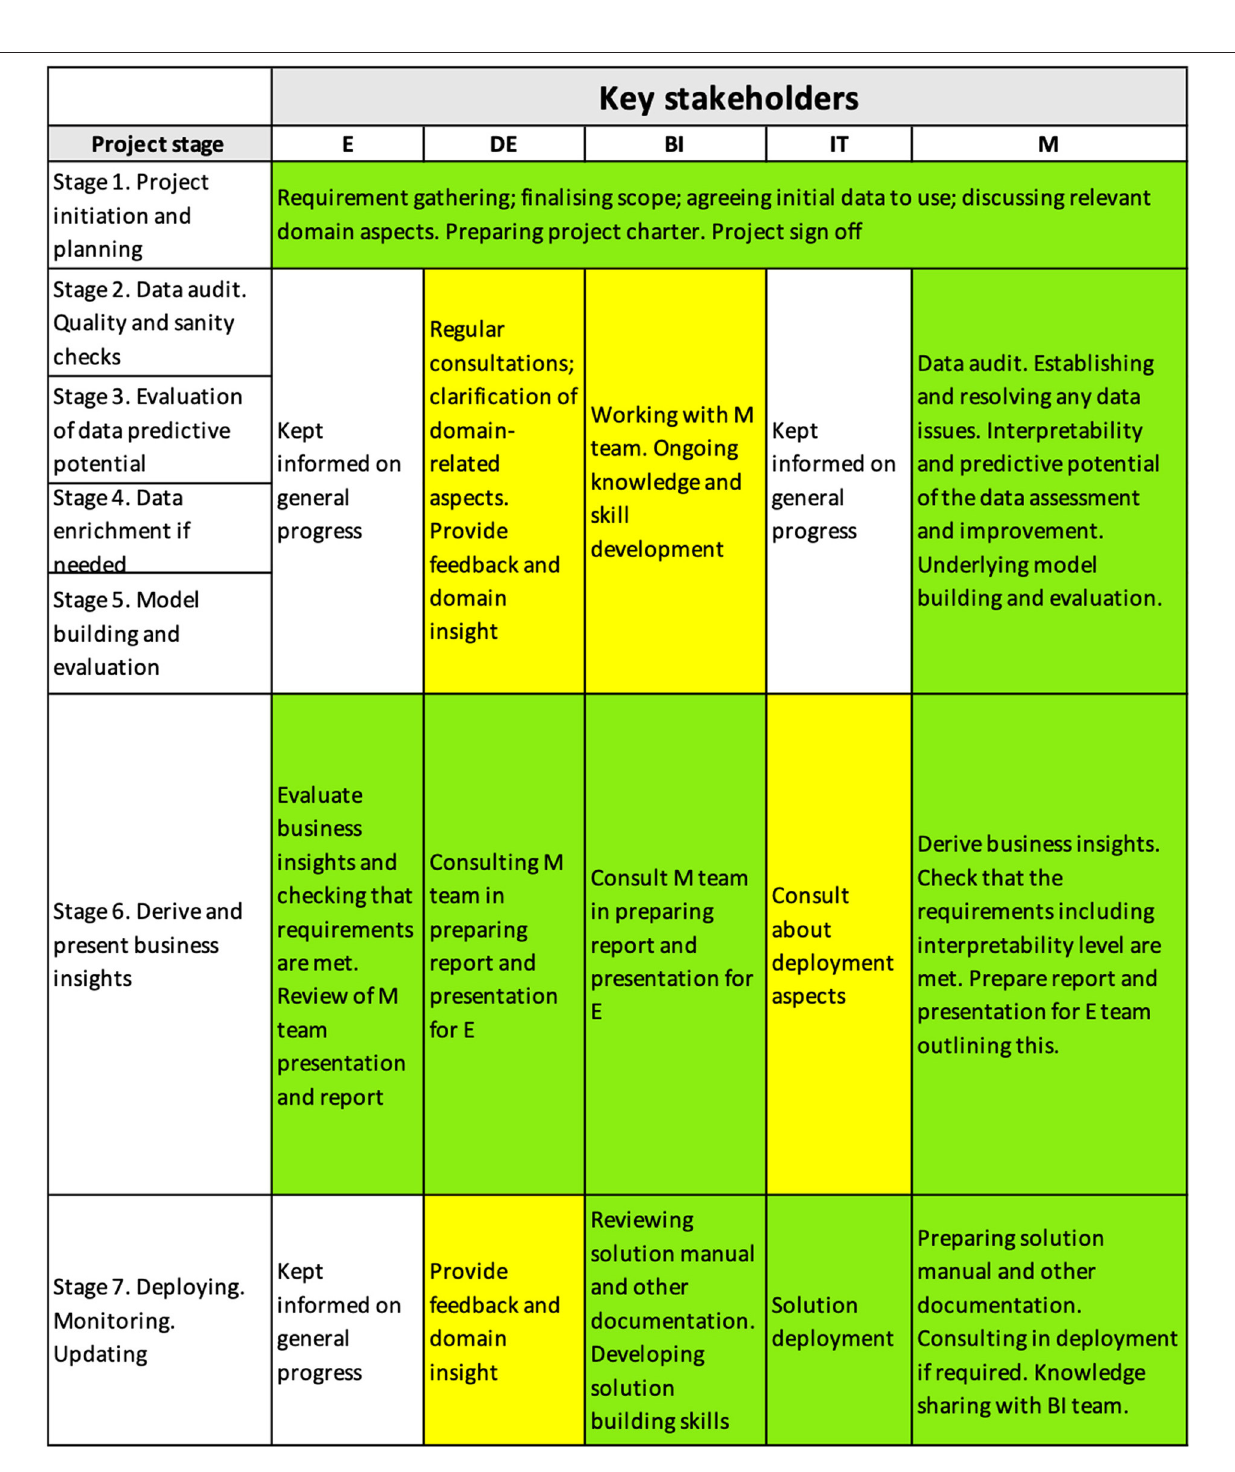
Further, we consider the content of the interpretability matrix for each of these stages, they are represented by the second, third, and fourth rows of interpretability